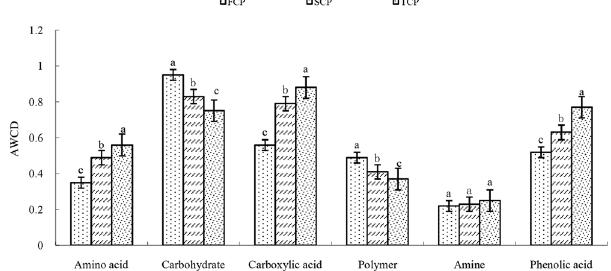
Figure 3. Mean catabolic activity per well for each substrate group in different generation